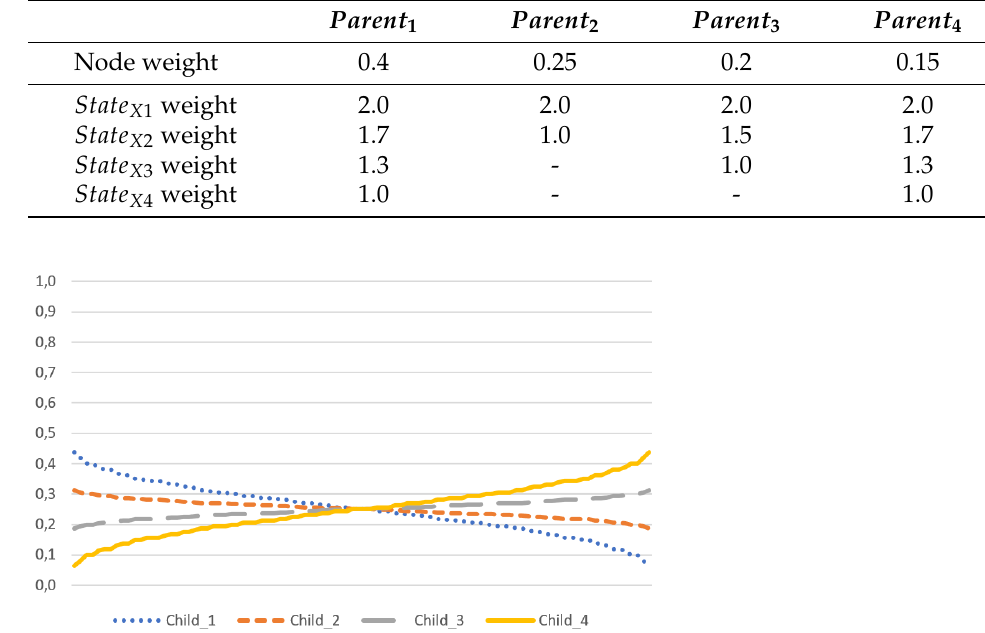
Table 2. The weights of the parent nodes and the weights of the child states.